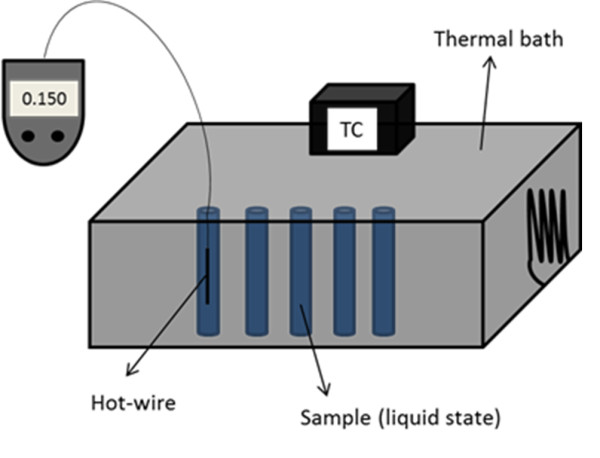
Experimental setup.